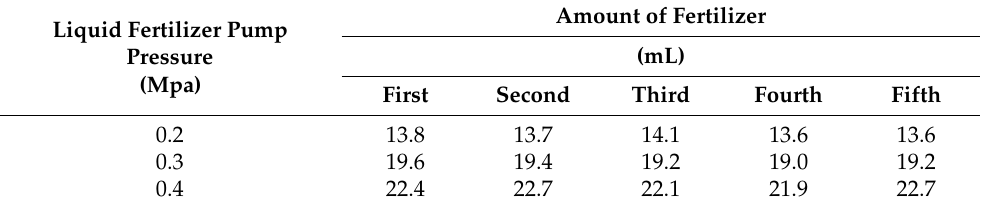
Table 4. Liquid fertilizer volume and time data.